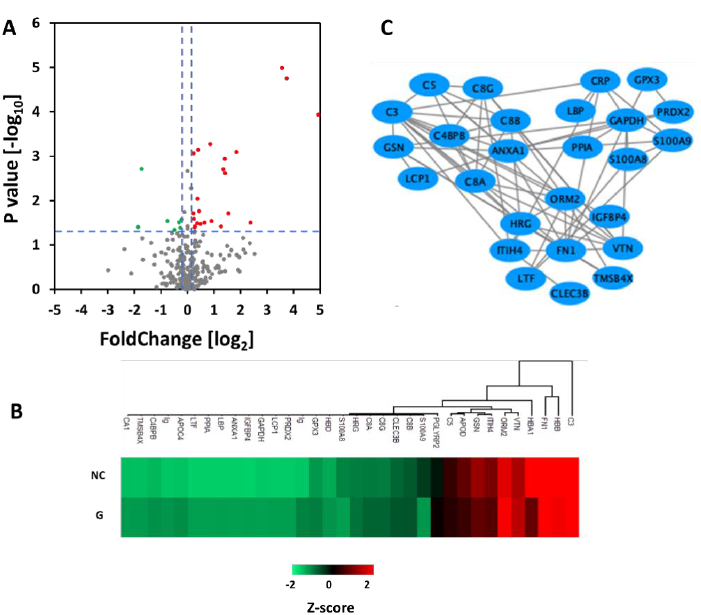
Figure 5. Comparison of differential proteins between the normal control group and gout group among the 24 plasma samples. ( A ) Volcanic diagram analysis of differential protein between the normal control group and gout group. ( B ) Cluster analysis of 32 differentially expressed proteins in plasma of patients with the normal control group and gout group. ( C ) Network correlation analysis of 32 differentially expressed proteins in plasma of patients with the normal control group and gout group.